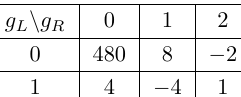
) = (1 , 0 , 1) in E , d 2 , d 3